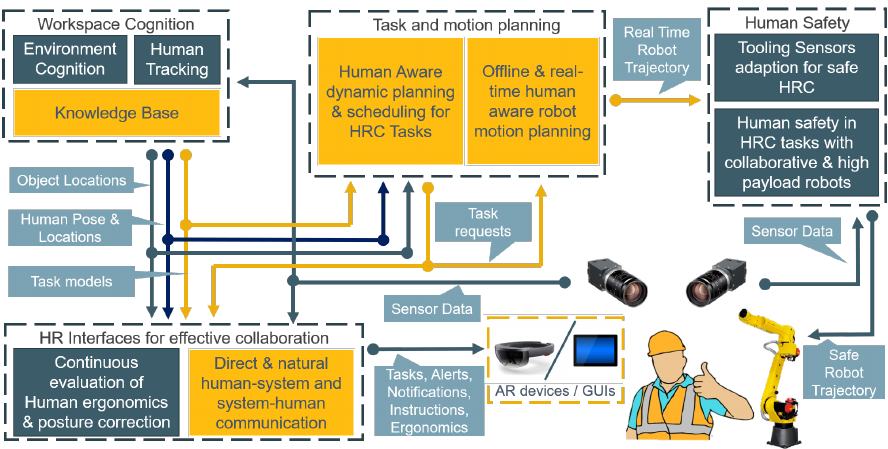
Figure 1. Overview of the SHAREWORK